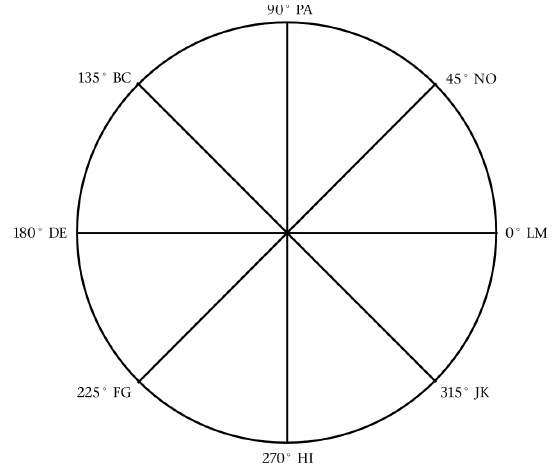
Figure 2: The octant version of the Interpersonal Circle The octant model distinguishes eight separate interpersonal behaviours or styles which include the assured-dominant (PA), competitive-mistrusting (BC), cold-hostile (DE), detached- inhibited (FG), unassured-submissive (HI), shirking (deferent)- trusting (JK), warm-friendly (LM) and social-exhibitionistic (NO)